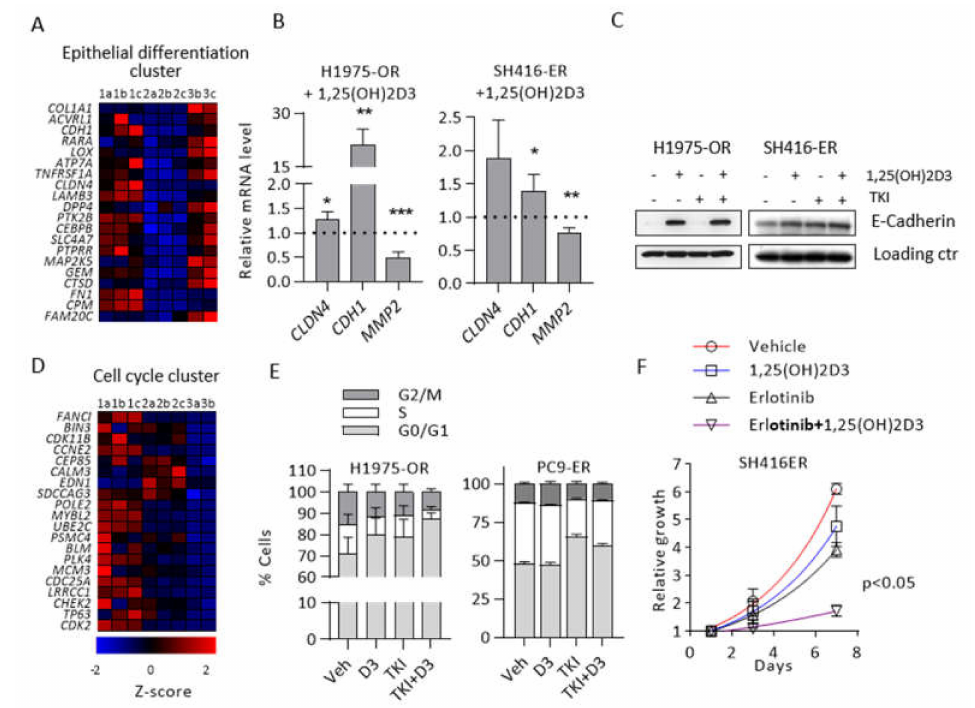
Figure 4. 1,25(OH)2D3 promotes epithelial di ff erentiation and cell cycle arrest. RNA sequencing and GSEA were performed in H1975 parental (1a, 1b, 1c) and H1975-OR cells treated with vehicle control (2a, 2b, 2c) or 1,25(OH)2D3 (3b, 3c). ( A ) Top 20 core enrichment genes from the Epithelial Di ff erentiation cluster. ( B ). Expression of select epithelial and mesenchymal markers was investigated by qRT–PCR in H1975–OR and SH416–ER cells treated with 1,25(OH)2D3 for 96 h. Expression level in vehicle-treated cells were set to 1 and are represented by the dotted line. * p < 0.05; ** p < 0.01; *** p < 0.001. ( C ) Cells were treated as indicated for 24 h and expression of E-cadherin was